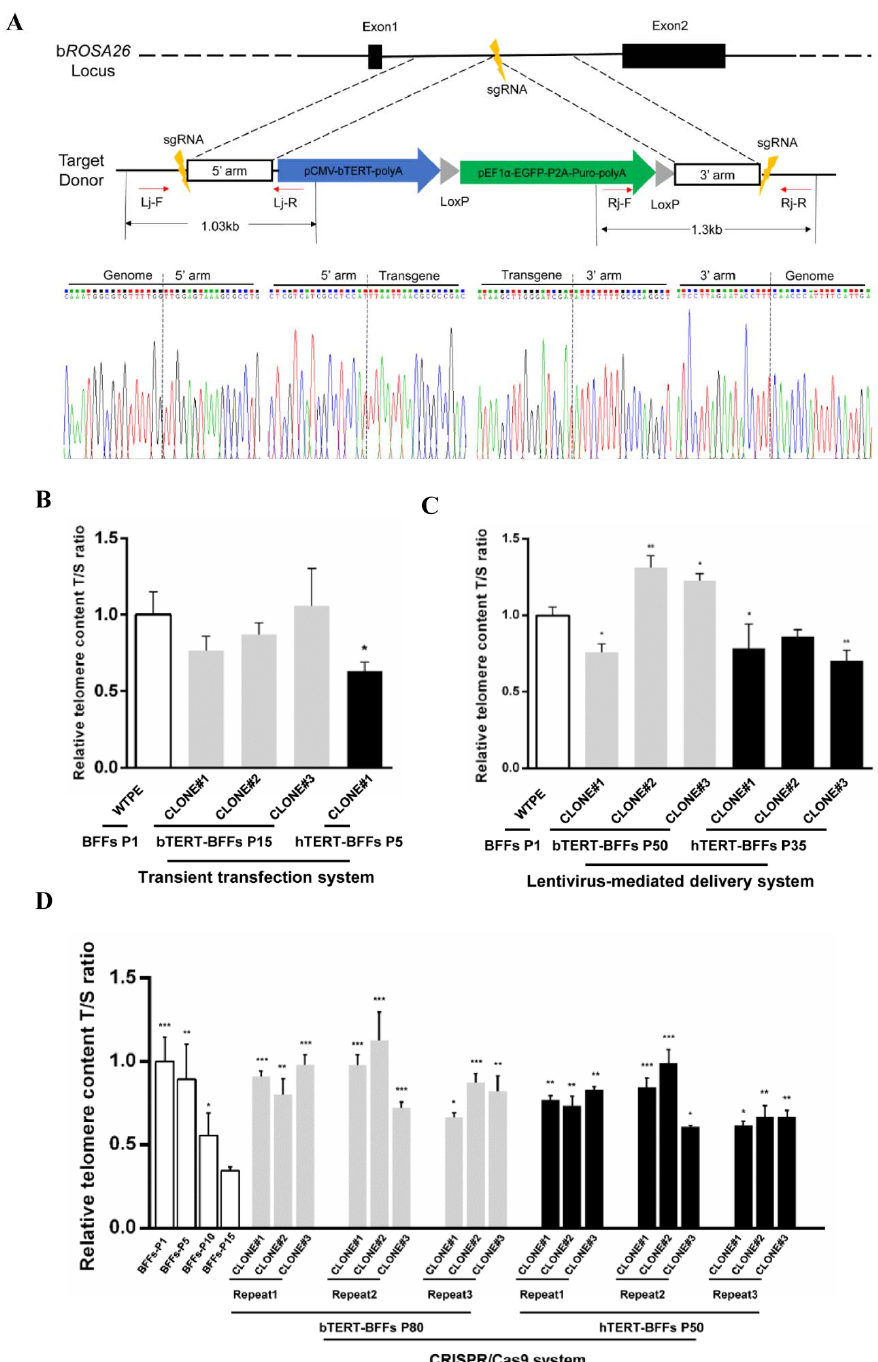
Figure 2. Immortalization strategy of HMEJ-based CRISPR/Cas9-mediated b TERT insertion at the b ROSA26 locus has great advantages in efficiency and cell viability. ( A ) Schematic overview of the screening of the individual colonies via HMEJ-based b TERT insertion at the b ROSA26 locus. Lj-F/Lj-R, 5 (cid:48) junction PCR primer; Rj-F/Rj-R, 3 (cid:48) junction PCR primer. Sanger sequencing confirmed the precise insertion of exogenous DNA. ( B ) Relative telomere length of wild-type 1st passage of BFFs, 15th passage of BFFs via transient transfection with b TERT , and 5th passage of BFFs via transient transfection with h TERT . “WTPE” represents wild-type BFFs. Bovine β -globin served as internal reference. ( C ) Relative telomere length of immortalized BFFs via lentivirus-mediated delivery with b TERT or h TERT . Bovine β -globin served as internal reference. ( D ) Relative telomere length of immortalized BFFs colonies integrated with b TERT or h TERT by the CRISPR/Cas9 system. Bovine β -globin served as internal reference. Data in ( B – D ) were mean ± s.d., n = 3 independent experiments, one-tailed Student’s t -test, * p < 0.05, ** p < 0.01, *** p < 0.001 vs. BFFs P1 ( B , C ) or BFFs P15 ( D